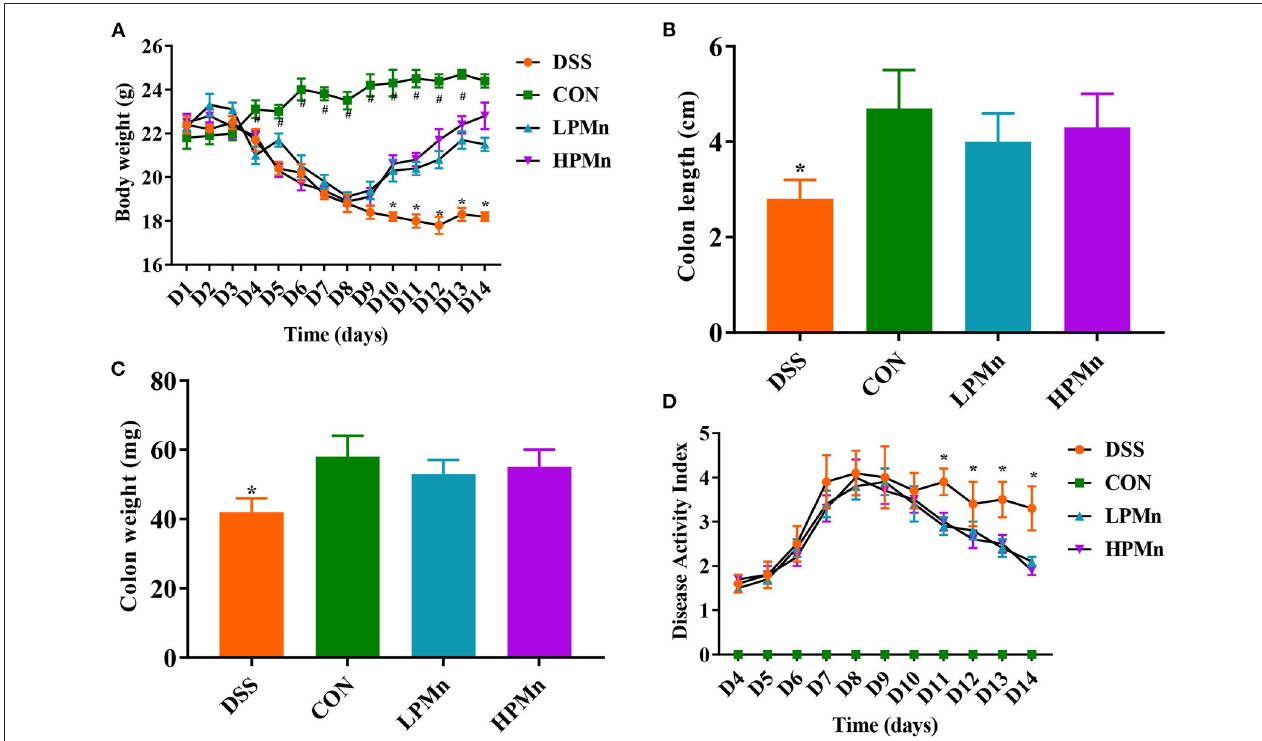
FIGURE 1 | Ulva polysaccharide-manganese alleviated DSS-induced colitis symptoms. (A) Body weight change. (B) Colon length. (C) Colon weight. (D) Disease activity index. Values are expressed as mean ± SEM, n = 7. * P < 0.05 (Significant difference between DSS group and other three groups); # P < 0.05 (Significant difference between CON group and other three